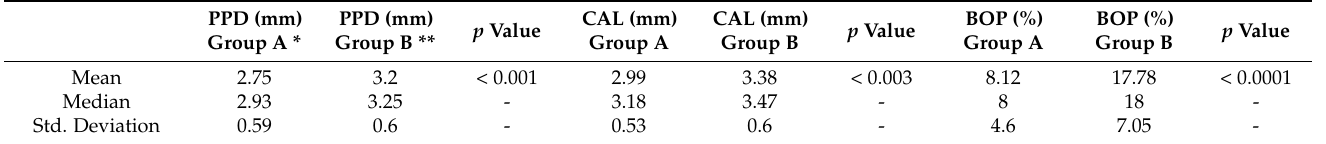
Table 3. Change of periodontal clinical parameters of both groups at 3 months.